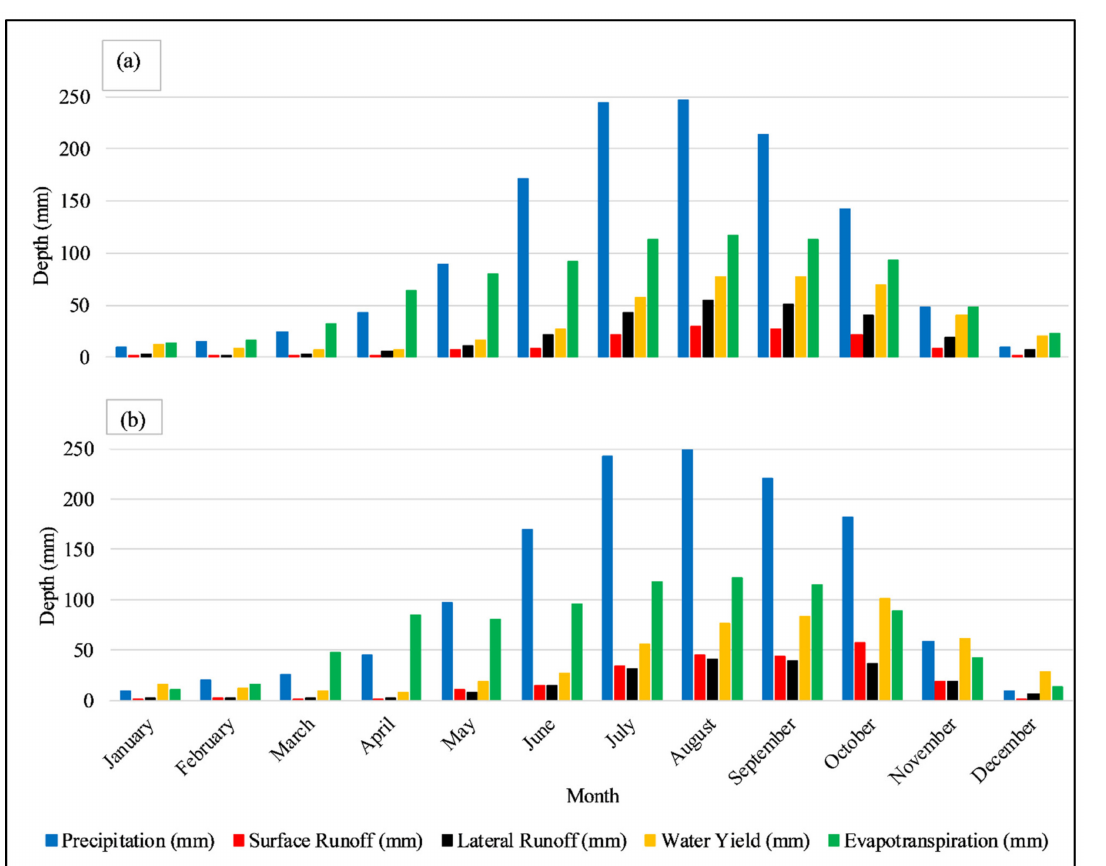
Figure 8. Mean monthly values of water balance components ( a ) Nagavali basin ( b ) Vamsadhara river